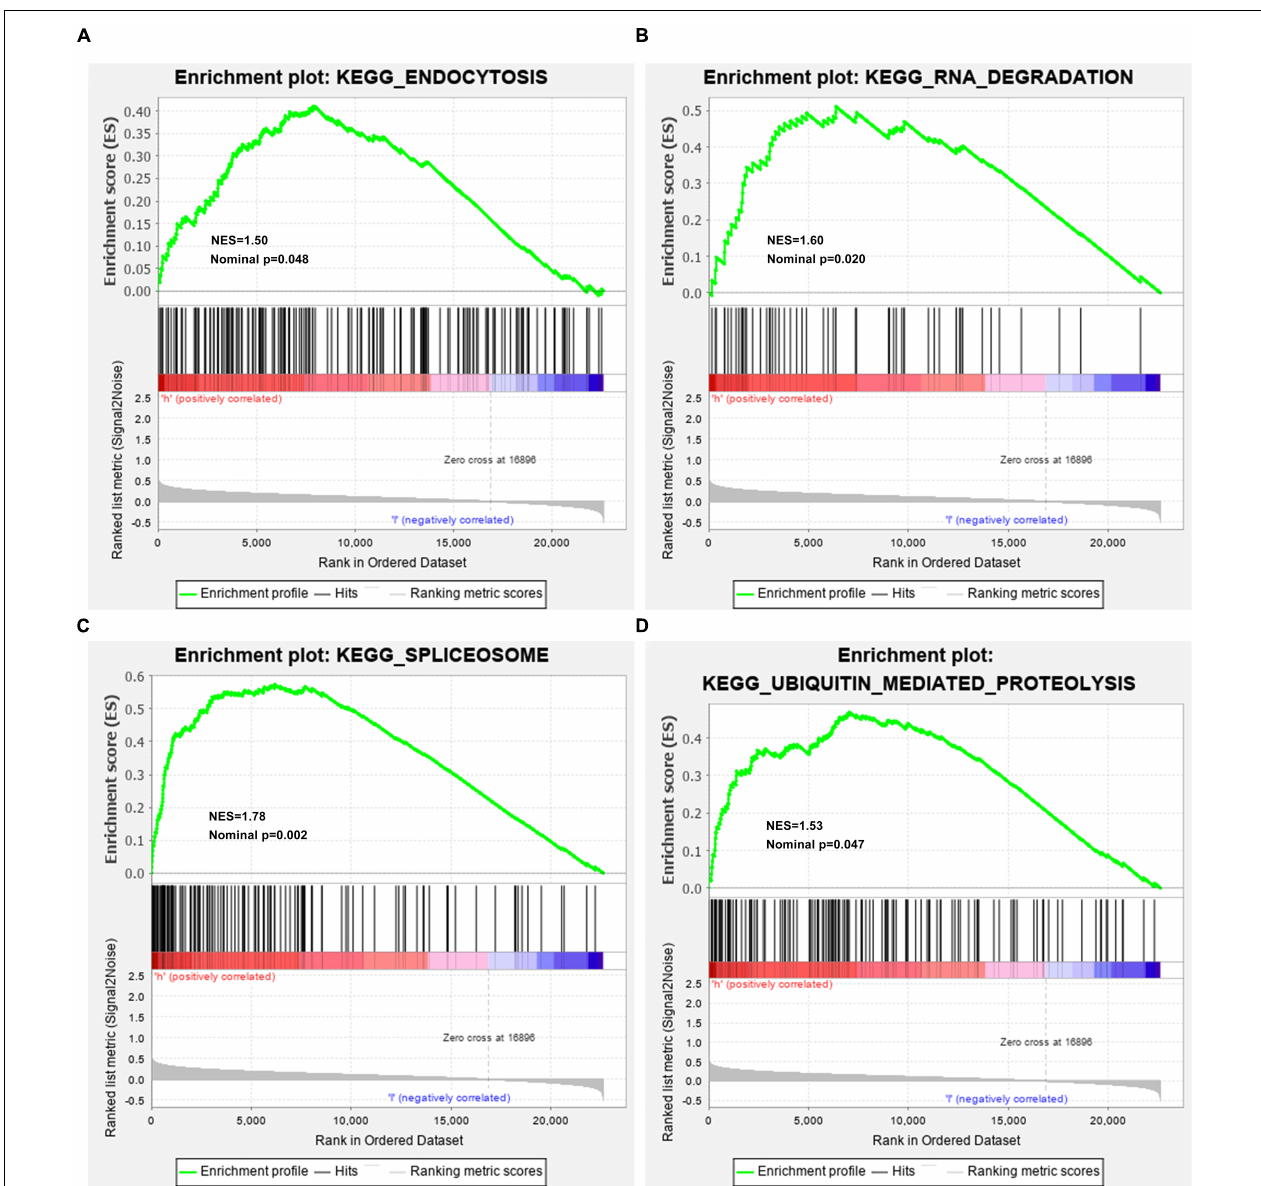
FIGURE 6 | Activated KEGG pathways in high-risk HBV-related HCC samples from the TCGA dataset by GSEA. (A) Endocytosis; (B) RNA degradation; (C) spliceosome; (D) ubiquitin-mediated